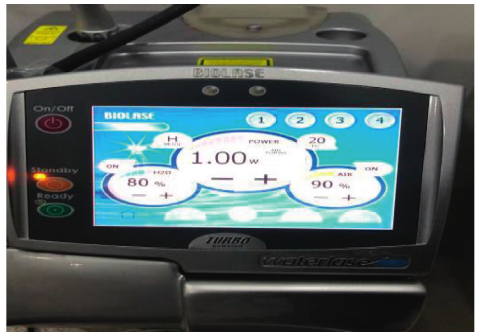
Figure 3: At 80% water and 90%